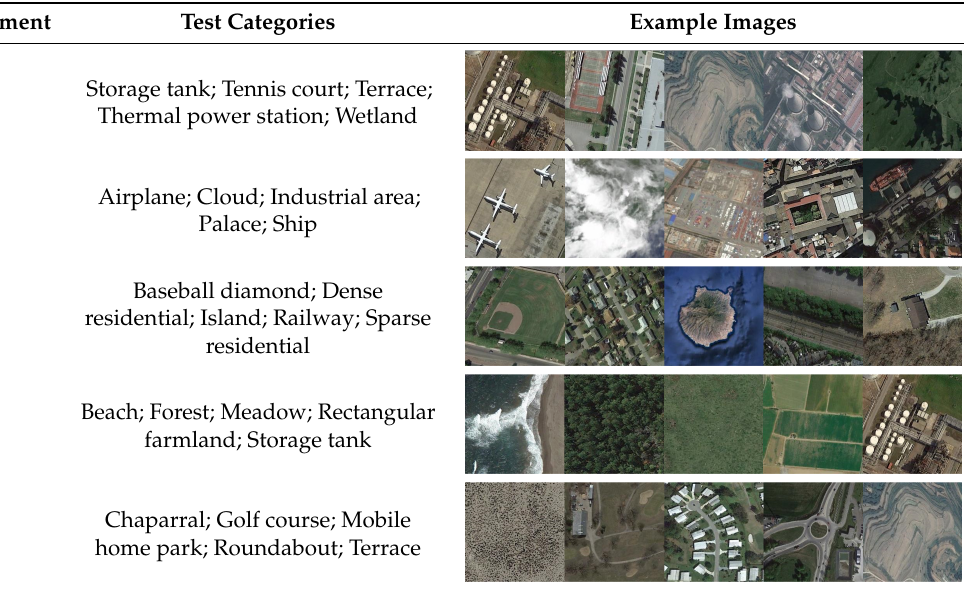
Table 1. Test categories and examples in each experiment on the NWPU-RESISC45